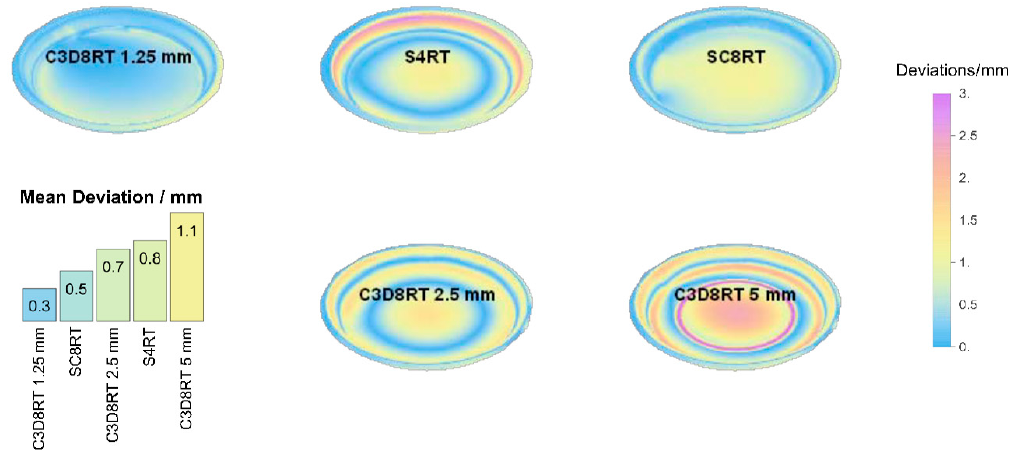
Figure 8. Dimensional deviations measured using 3D scanning for the different element types and sizes.